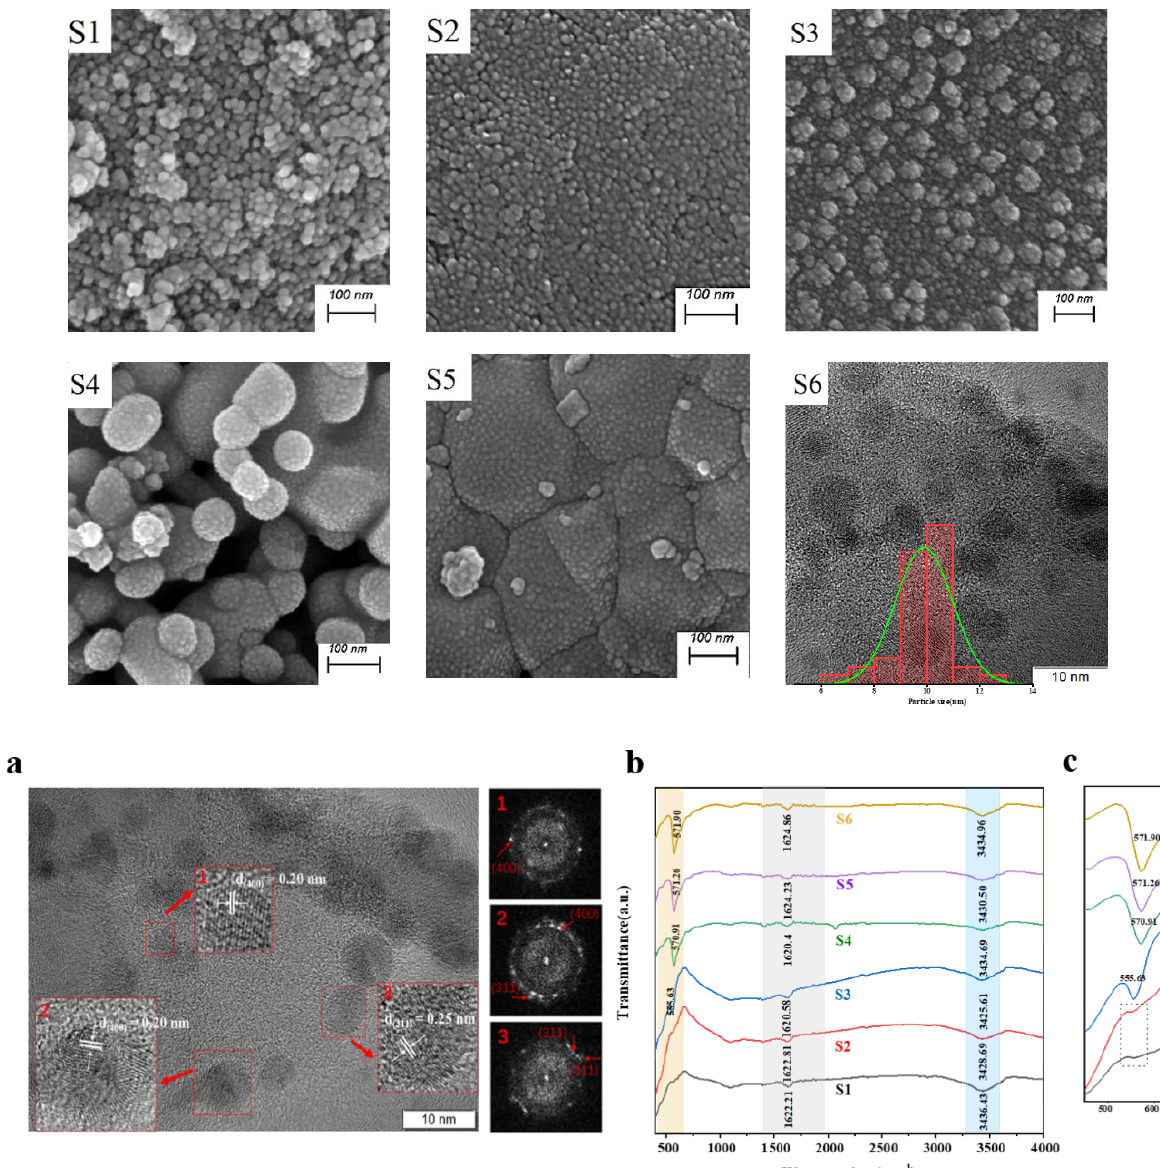
Figure 2. ( S1 – S5 ) SEM images of Fe 3 O 4 /FeO composites with different percentages. S6 . TEM image of Fe 3 O 4 nanoparticles and particle size distribution (in the inset). ( a ) HRTEM images of Fe 3 O 4 nanoparticles and diffraction rings of Fe 3 O 4 nanoparticles. ( b ) FT-IR spectra of the nanoparticles. ( c ) FT-IR spectra with an enlarged yellow area.